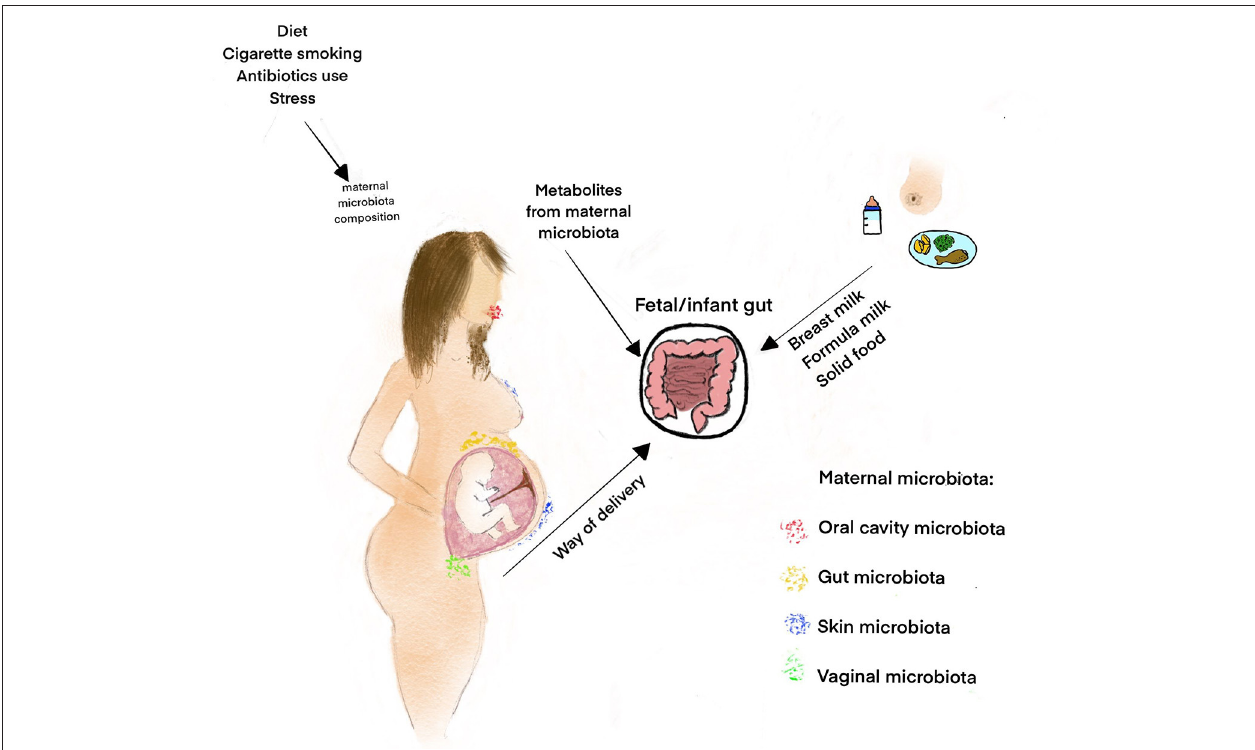
FIGURE 1 | Factors influencing the gut microbiota composition in the fetal period and infancy. Some factors like maternal diet, obesity, cigarette smoking, and the use of antibiotics influence the maternal microbiota composition and, consequently, fetal microbiome ( 25). The fetal microbiome probably originates both from the vagina through ascendant colonization and from the maternal oral cavity/gut, through the bloodstream (5, 11). The maternal microbiota metabolites transported to the fetus through the placenta regulate fetal development, including gut maturation and prepare the offspring for colonization during delivery and postnatal life ( 6, 26). The other important factors that influence the early microbiota composition and diversity are the way of delivery, contact between the infant and the mother’s skin and feeding introduction ( 27,